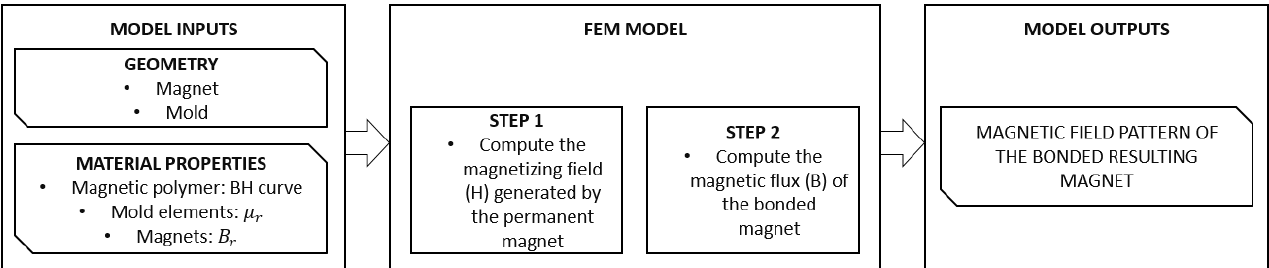
Figure 2. Workflow of the proposed FEM model.